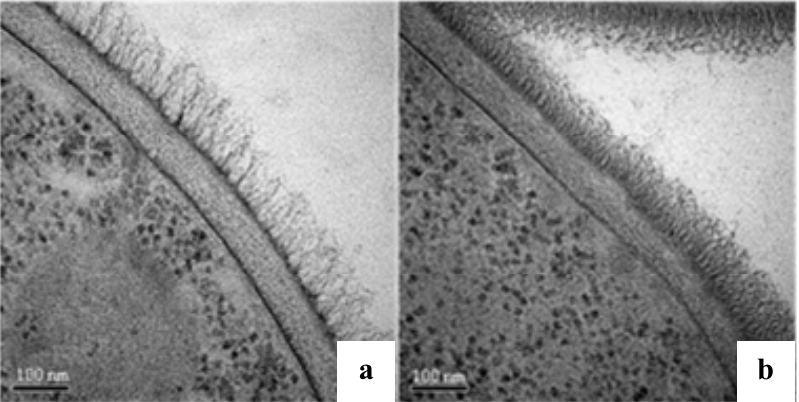
Figure 2. Ultrastructural analysis of the C. albicans yeast cell surface. ( a ) Transmission electron microscopy of cells without treatment ( b ) And cells treated with 156 µg/mL of subfraction F2 for 16 h. Magnification of 130,000 ×